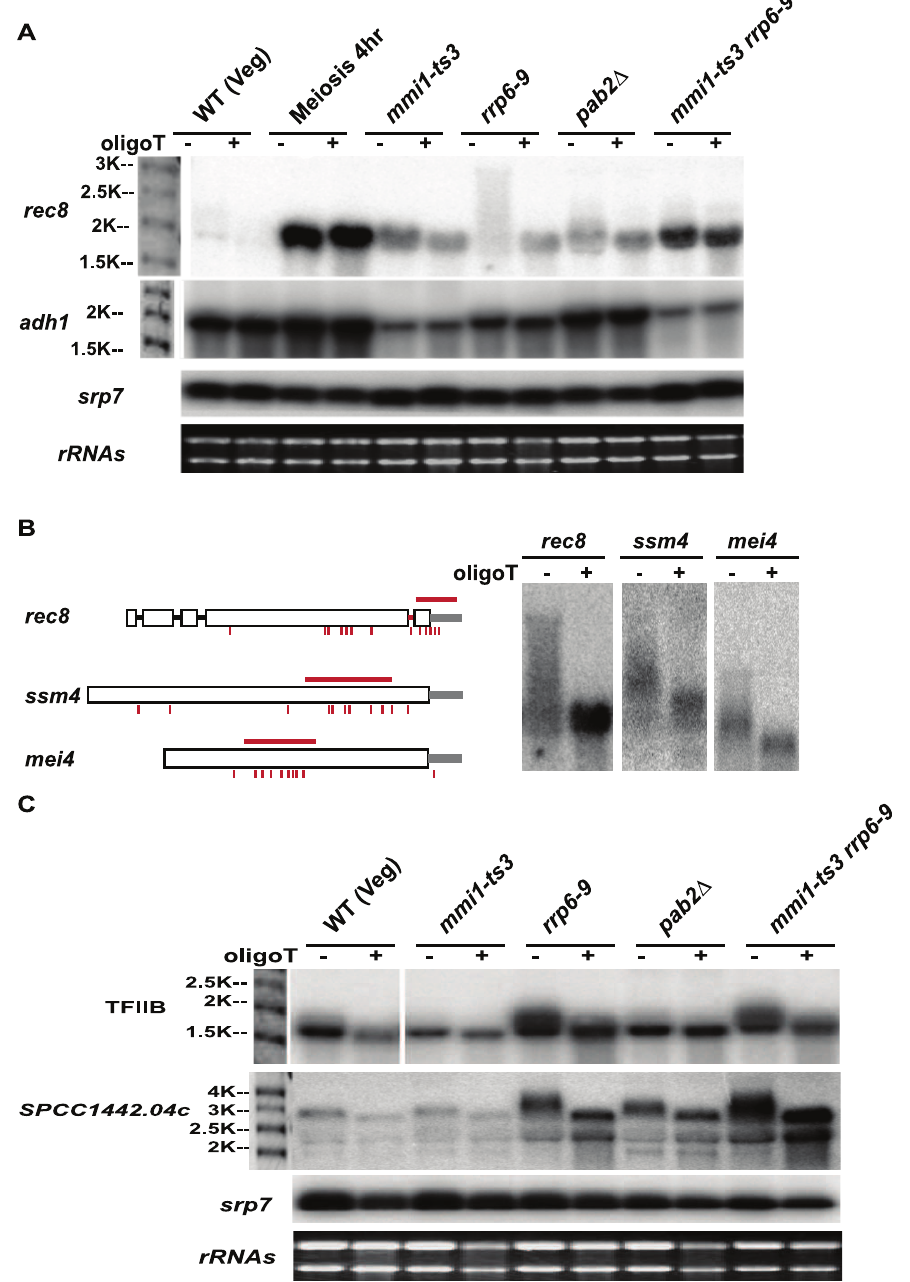
Figure 5. Northern blot analysis of transcript size and polyA tail length. (A) Total RNA was isolated from WT or mutant cells in vegetative growth or from 4 hours in meiosis. RNA was treated with RNase H in the absence (-) or presence ( + ) of oligo d(T) to cleave off the polyA tail. RNAs ( rec8 , and adh1 as a control) were then analyzed by strand specific Northern blot. Hybridization to srp7 and ethidium bromide staining of rRNAs are shown below each blot as loading and RNA quality controls. (B) Gene structure of three Mmi1 regulated genes, rec8, ssm4 and mei4 , are drawn to scale. The red line above each gene indicates the mapped DSR sequence [3] and the red bars under the gene indicate the putative Mmi1 motif. RNA was isolated from the rrp6–9 mutant and subjected to RNase H treatment in the absence ( 2 ) or presence ( + ) of oligo d(T). (C) Analysis of two Rrp6- responsive genes that are independent of Mmi1. These are SPAC16E8.16 , which encodes TFIIB, and SPCC1442.04c . A blank space in the TFIIB panel indicates removal of irrelevant lanes. doi:10.1371/journal.pone.0026804.g005 sites. Similarly, with the wild-type ribozyme, the ribozyme- (Figure 6C, lane 3 to 6), once again suggesting that Mmi1 is generated end (RZ band) is only made when transcripts extend inhibiting cleavage. However, this inhibition is modest: about 95% past PAS1 and PAS2, and in this case the RZ band is seen in WT, of transcripts are cleaved and polyadenylated at the normal sites, rrp6–9 and pfs2–11 mutants, but not in the mmi1-ts3 mutant PAS1 and 2, while the other 5% read-through. This estimate is